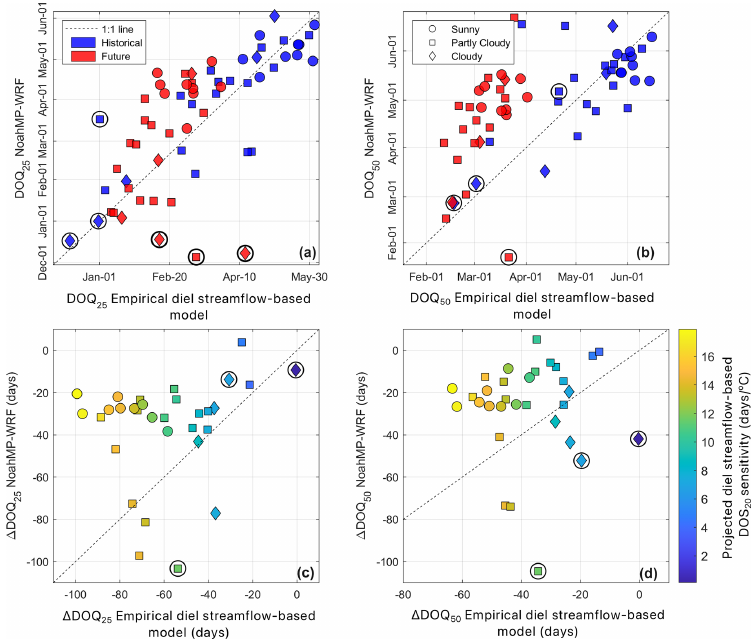
Figure A7. Same as Fig. 9 but using streamflow timing metrics from NoahMP-WRF for a RCP8.5 pseudo global warming scenario, calculated using surface runoff only instead of using surface plus subsurface runoff (as in Fig. 6). Note the improved fit in historical DOQ 25 ; however, this analysis yields very similar results to those in Fig. 6, with NoahMP-WRF streamflow simulations being much less sensitive to climate change than the empirical diel streamflow-based model suggests. Panels (a) and (b) compare historical against projected values between NoahMP-WRF and the empirical diel streamflow-based model. Panels (c) and (d) compare the projected change (future minus historical) between NoahMP-WRF and the diel streamflow-based model, colored by the sensitivity of DOS 20 to climate change as projected by the empirical diel streamflow-based model (Fig. 5b). Symbols surrounded by black circles indicate sites that were excluded from the regression analysis in Fig. 3 (rainier site ID 24, 25, and 31). Symbols (circle, square, and diamond) represent the historical mean annual percentage of clear-sky snowmelt days, where sunny sites have > 90% clear-sky snowmelt days, partly cloudy have between 70% and 90%, and cloudy have < 70%; clear-sky snowmelt days are defined as those with more than 80% of the potential clear-sky solar radiation. We make no inference about the cloudiness condition of snowmelt days under the RCP8.5 pseudo global warming climate scenario; however, red symbols (upper panels) follow the same symbology for easier